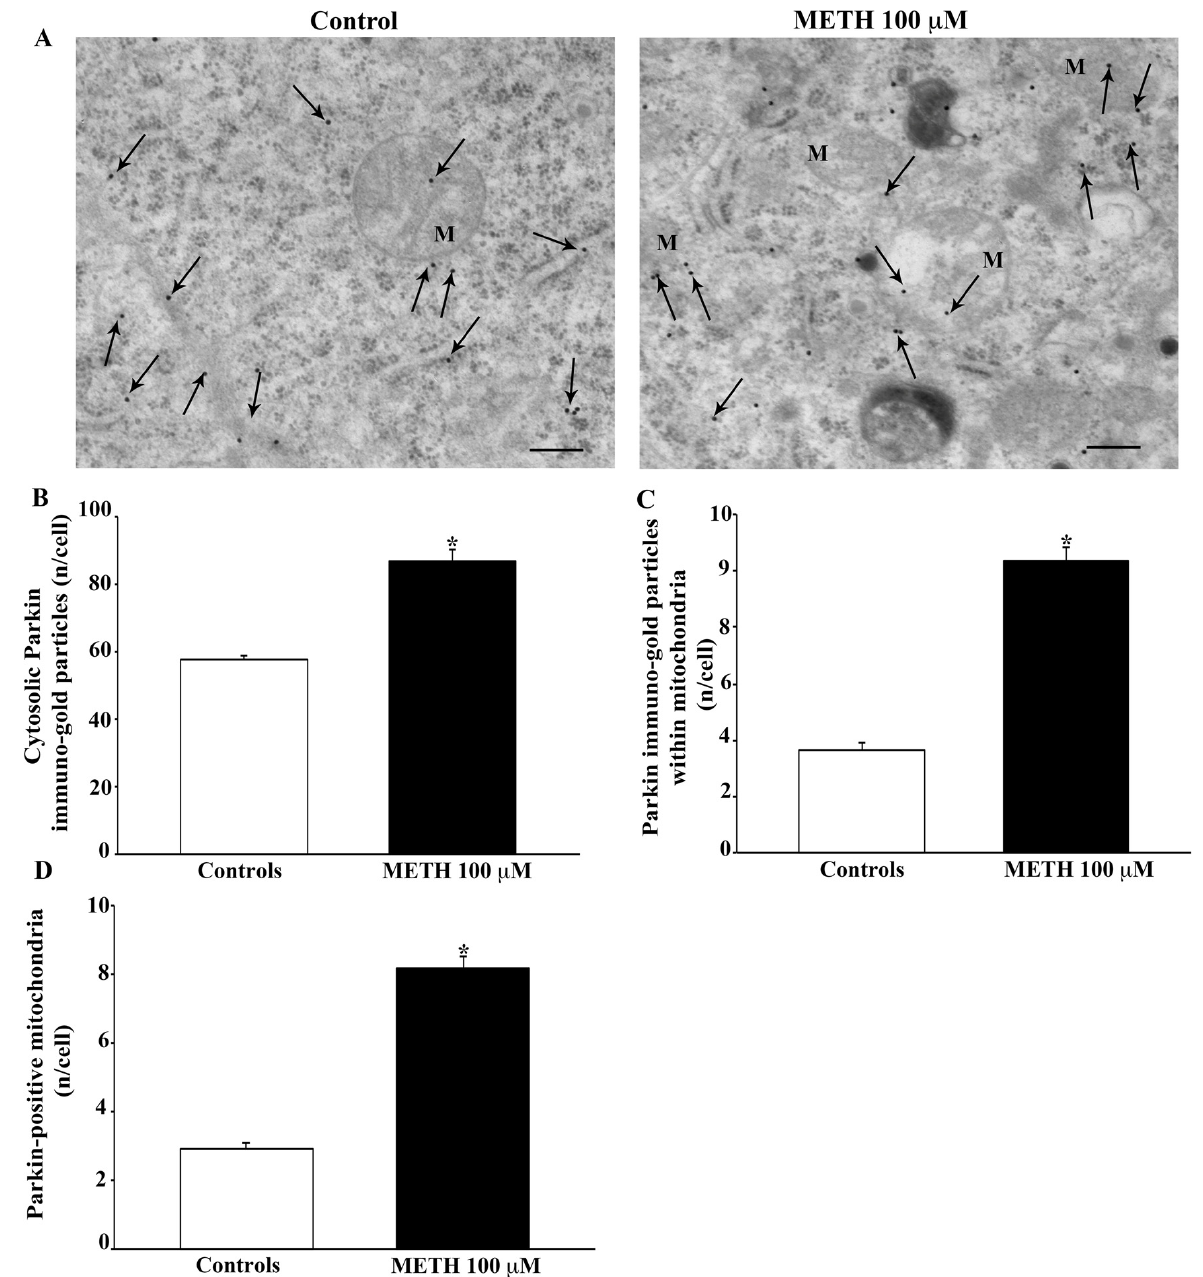
Figure 14. METH increases the protein, Parkin. ( A ) Representative TEM micrographs showing Parkin particles from control and following METH 100 µ M. Arrows point to Parkin immunogold particles within cytosol and mitochondria (M). Graph ( B ) reports the number of Parkin immunogold particles within the cytosol. Graph ( C ) reports the number of Parkin immunogold particles within mitochondria. Graph ( D ) indicates the number of Parkin-positive mitochondria. Values are given as the mean ± S.E.M from N = 50 cells per group. * p ≤ 0.05 compared with controls. Scale bars = 170 µ m. The presence of Pink1, which is very scattered in the cytosol, was increased following administration of METH 100 µ M, as shown in the representative pictures of Figure